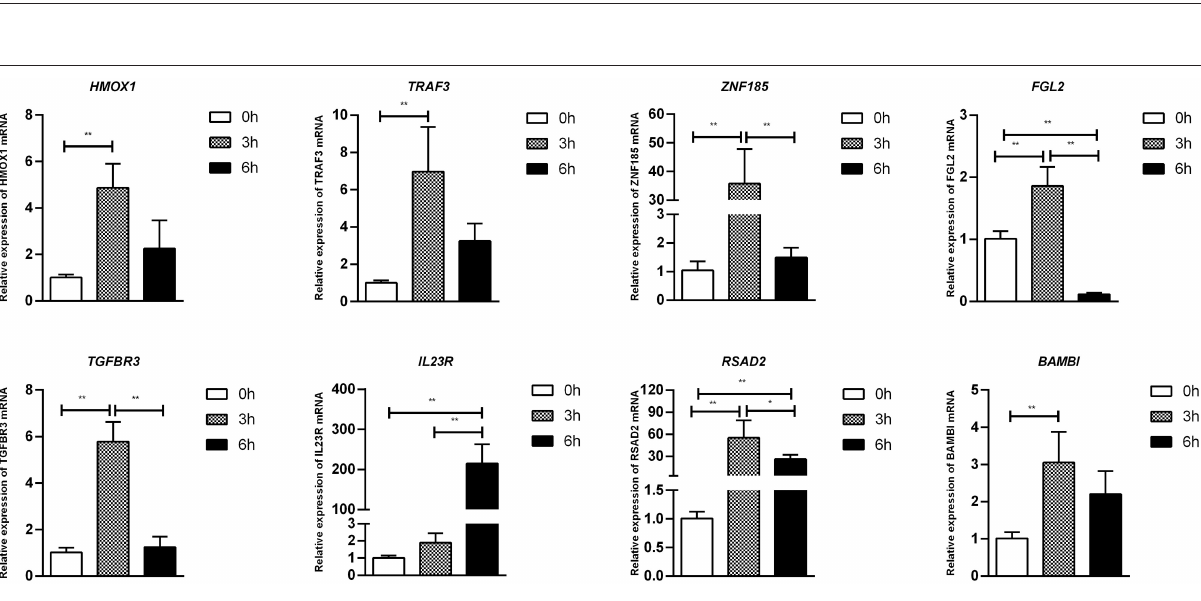
Frontiers in Veterinary Science | www.frontiersin.org